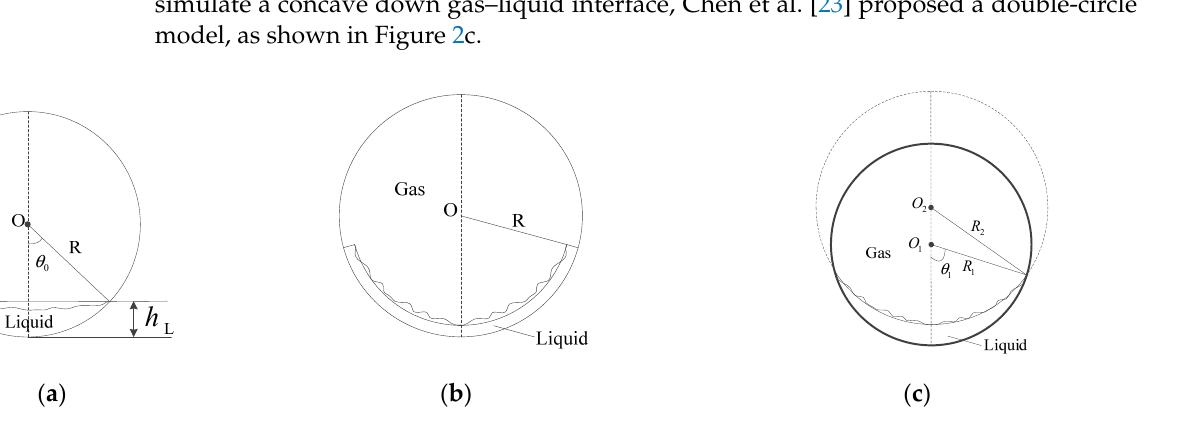
Figure 2. The existing models for stratified gas–liquid flow: ( a ): flat interface model; ( b ): apparent rough surface model; ( c ): double circle model.